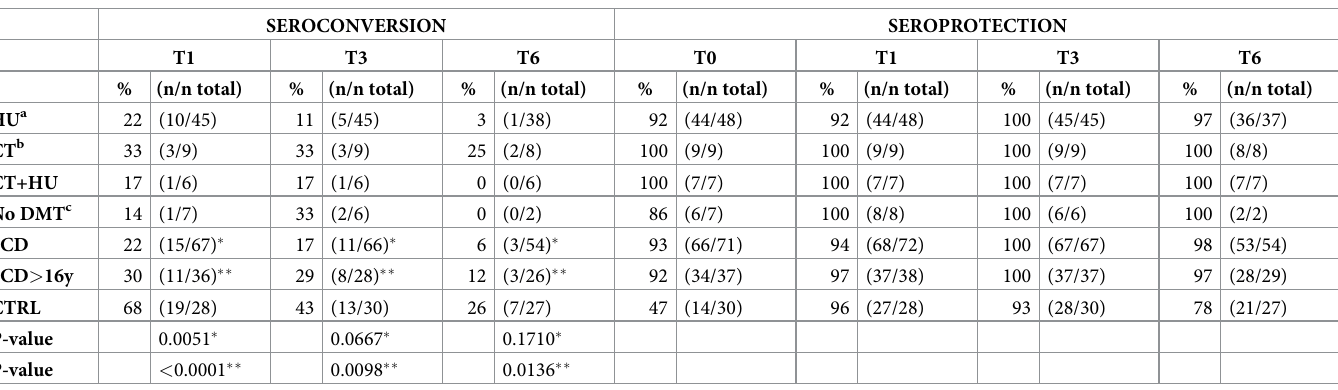
Table 2. Seroconversion and seroprotection